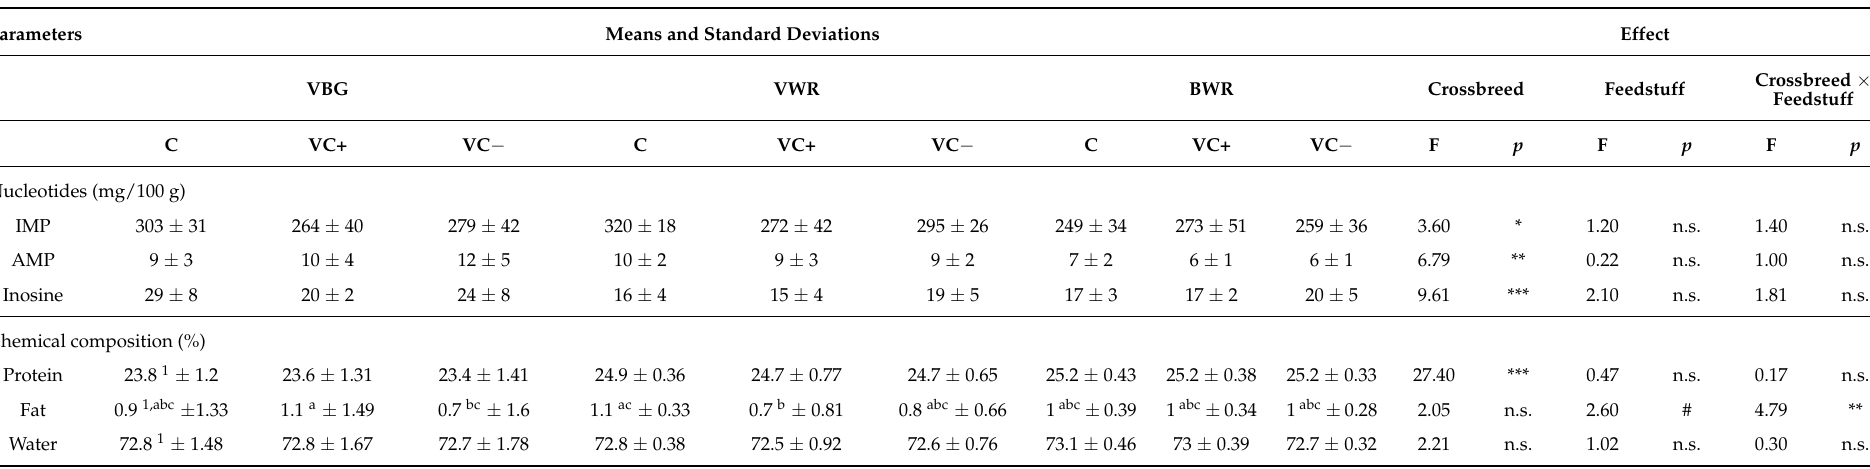
Table 4. Means, standard deviations and crossbreed, feedstuff and interaction effect for flavor-related nucleotides and proximal composition of samples.